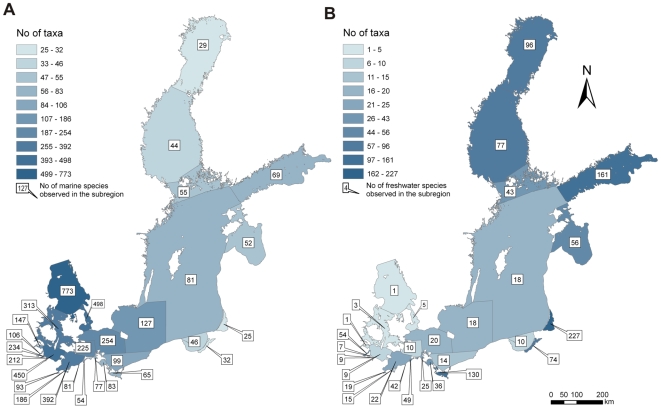
Sub-regional distribution of (A) marine and (B) freshwater taxa in the Baltic Sea: case of macrozoobenthos.Projection: ERTS89_LAEA CRS (Lambert Azimuthal Equal Area projection, ETRS89 datum).